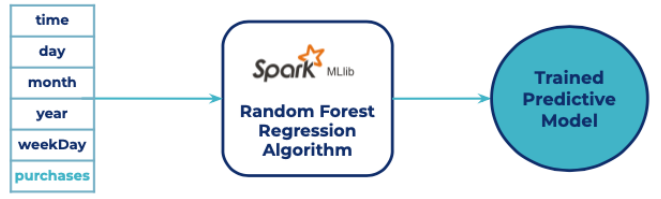
Figure 7. Training pipeline.